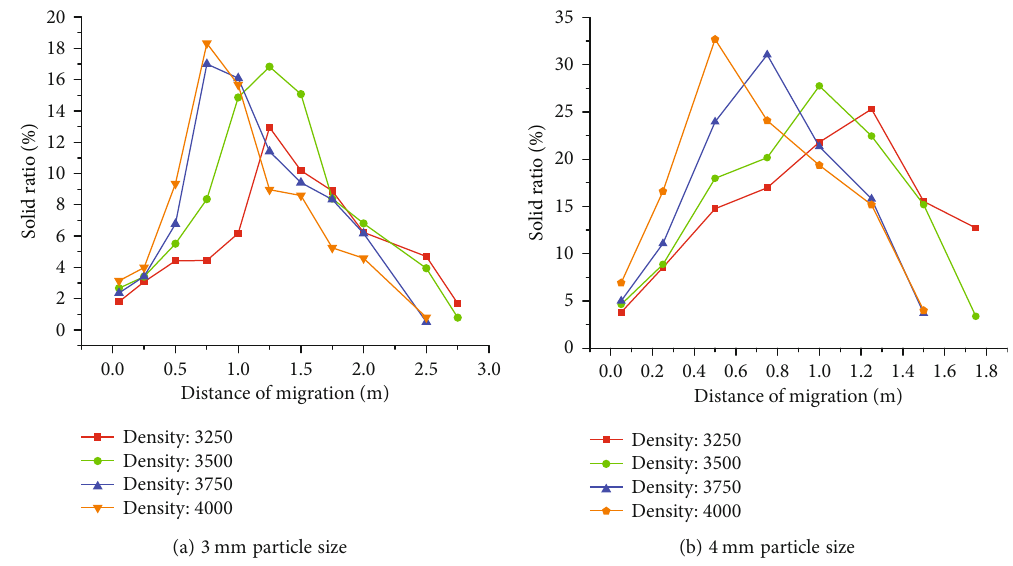
Figure 9: Change curves of solid ratio of aggregates with di ff erent particle sizes as a function of fl ow distance.